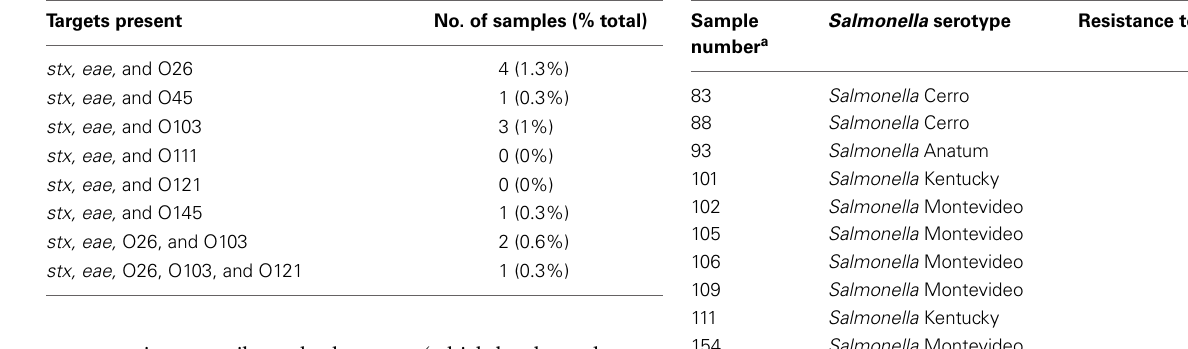
Table 3 | PCR screen results for non-O157 STEC serogroup and virulence gene distribution in 308 ground beef samples analyzed.